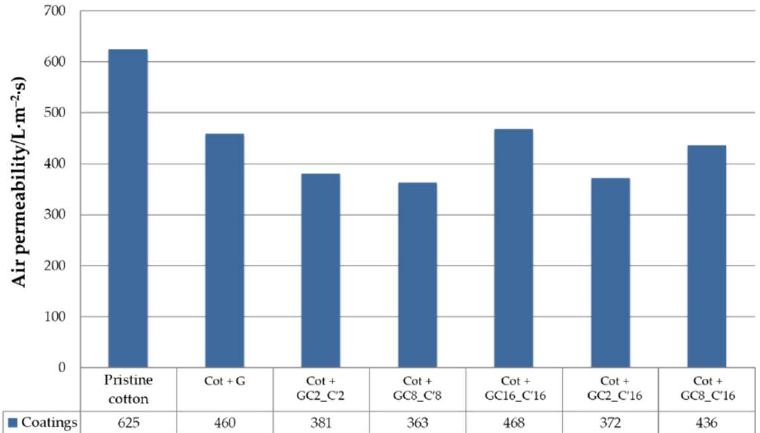
Figure 15. Histogram of the air permeability of the cotton fabrics treated by the nanocomposite